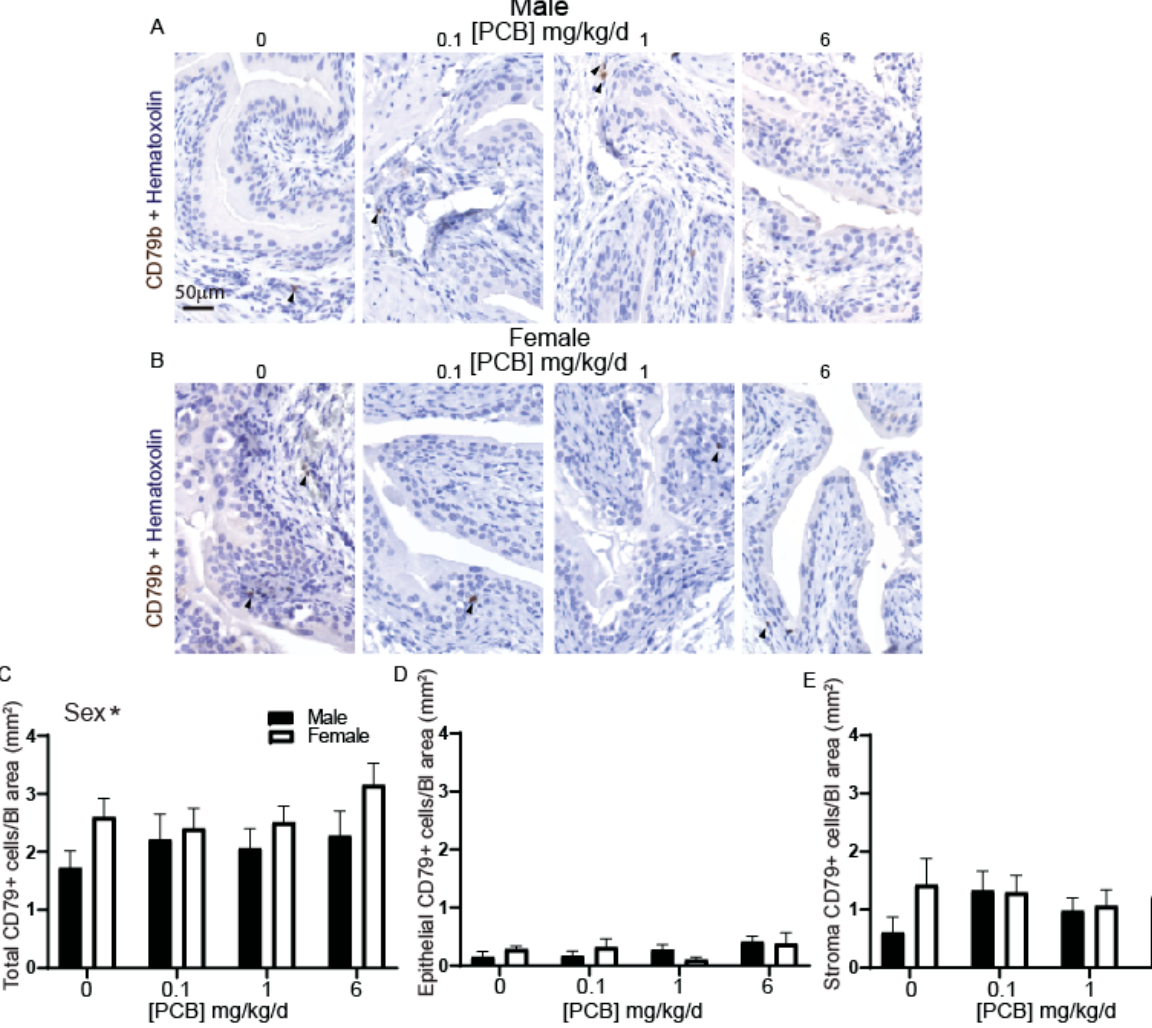
Figure 2. Sex influences CD79b-positive immune cells in bladders of developmentally exposed mice. Mice were exposed to PCBs via maternal diet through gestation and lactation. Bladders were collected from young male and female offspring at postnatal day (P) 28–31 for immunohistochemistry. Representative images of ( A ) male and ( B ) female mouse bladders at each PCB treatment group incubated with antibodies targeting CD79b (brown) to label immune cells and hematoxylin (purple) to label all nuclei. Quantification of ( C ) total cells CD79b positive within bladder, ( D ) epithelial cells CD79b positive within bladder, and ( E ) stromal cells CD79b positive within the bladder. Results are the mean ± SEM, n = 4–6 bladders per treatment group. * indicates significant differences at p < 0.05, as determined using two-way ANOVA.